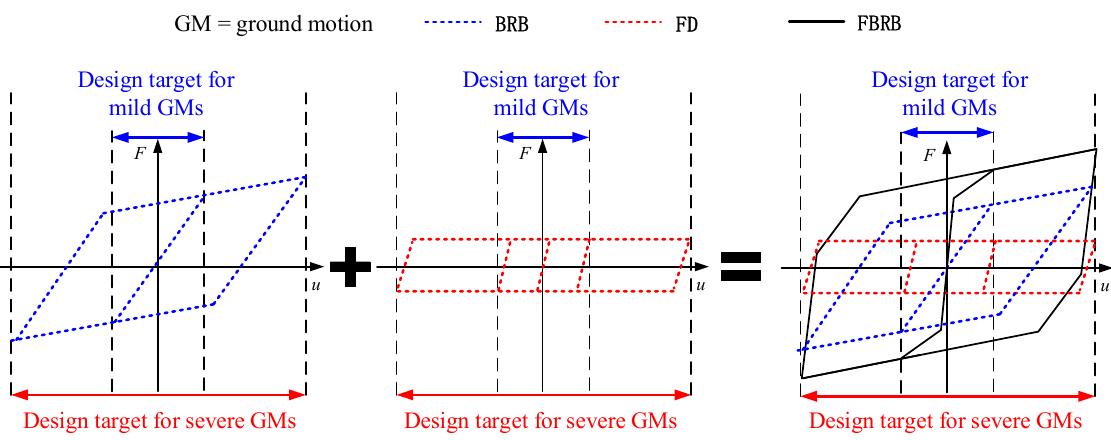
Figure 2. Simplified hysteretic models for BRB, FD, and FBRB.